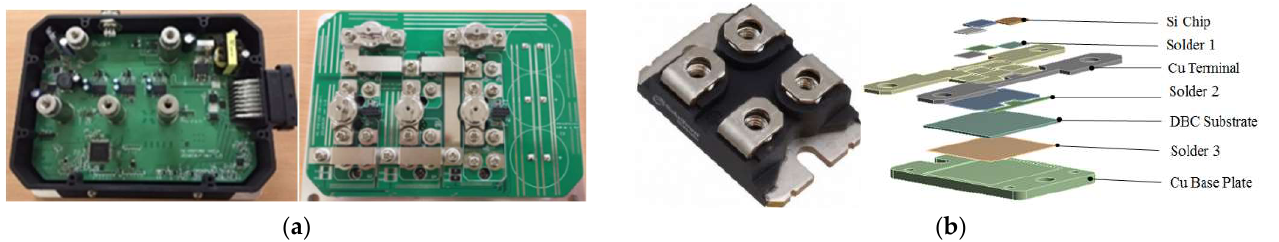
Figure 1. ( a ) Three-phase bridge inverter and ( b ) power MOSFET module and explosive view.